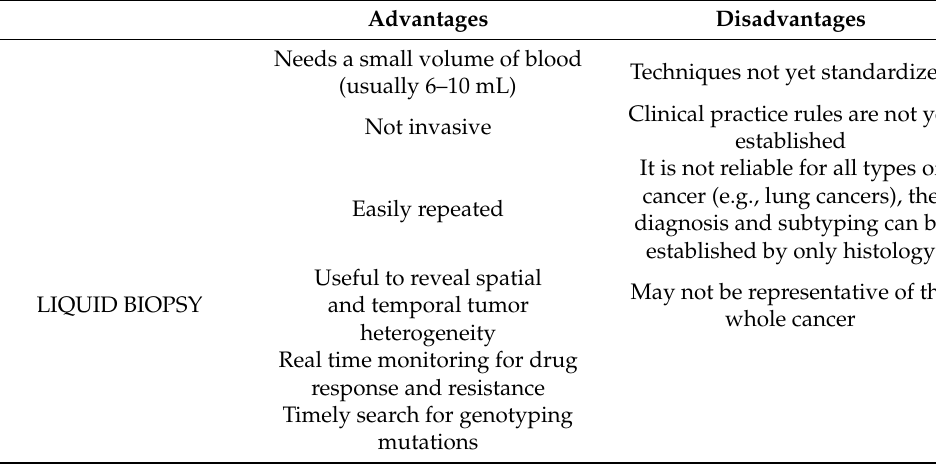
Table 1. Advantages and disadvantages of liquid